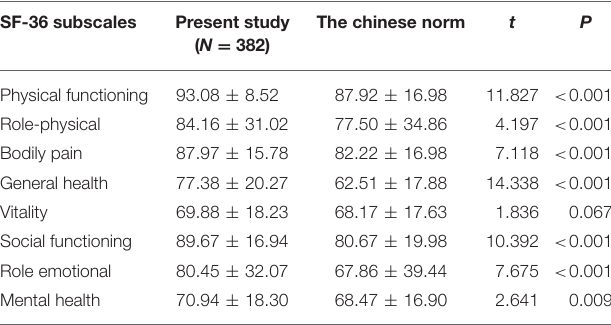
TABLE 3 | Comparing the health-related quality of life (HRQoL) with the general Chinese norms. SF-36